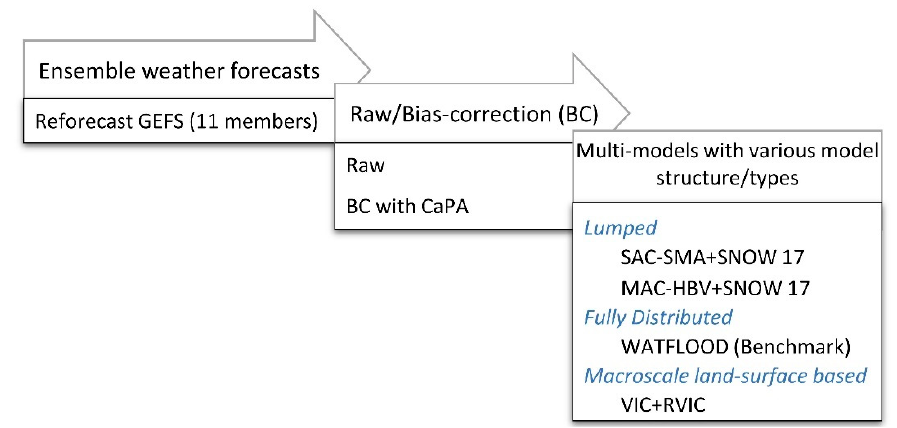
Figure 2. Illustration of the methodology adopted.